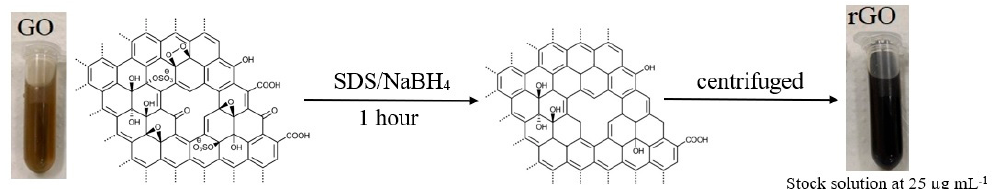
Figure 1. Schematic representation of reduced graphene oxide synthesis procedure.